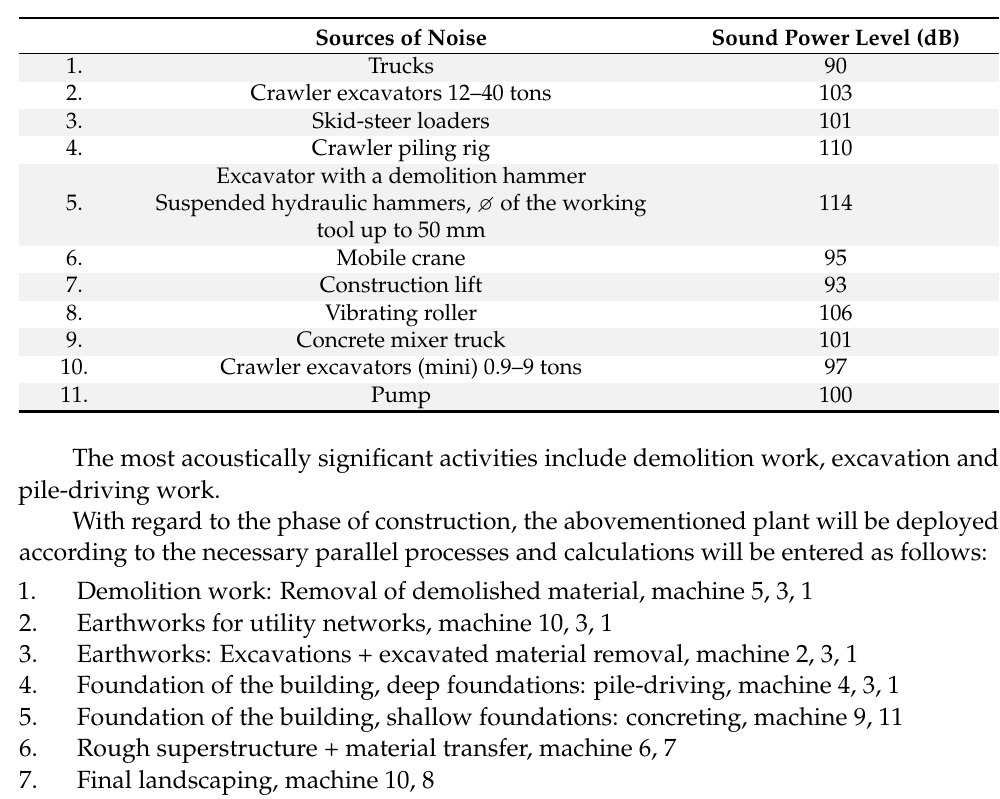
Table 2. Expected sources of construction